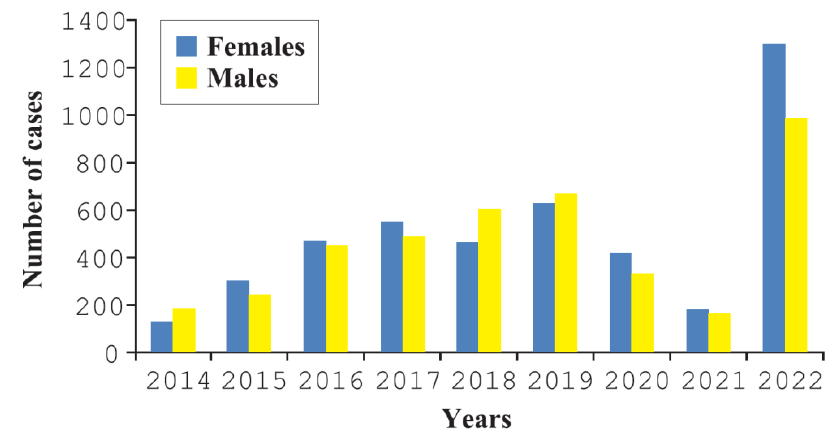
Figure 1. Number of hospitalizations of Ukrainian patients by sex, 2014 – 2022 .